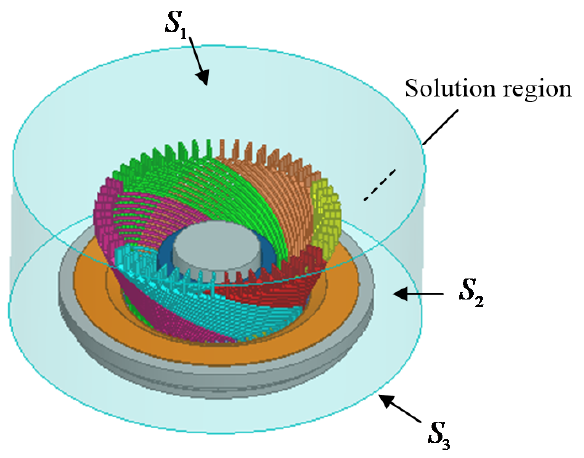
Figure 3. Solution region of the 3D transient electromagnetic field.